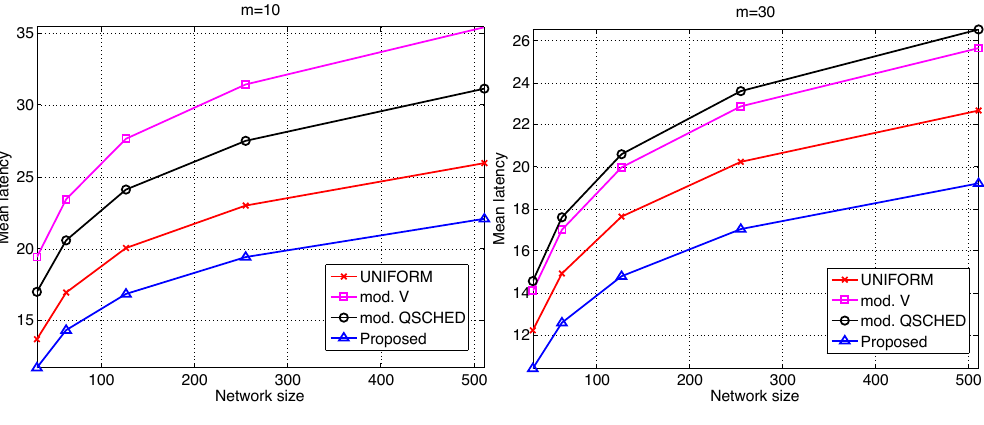
Figure 9. Comparison of the mean latency for different random access schemes.